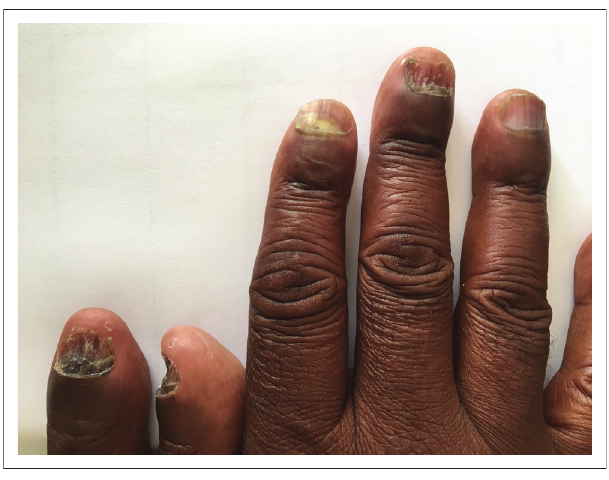
FIG URE 1: Proximal onychomycosis affecting four digits.